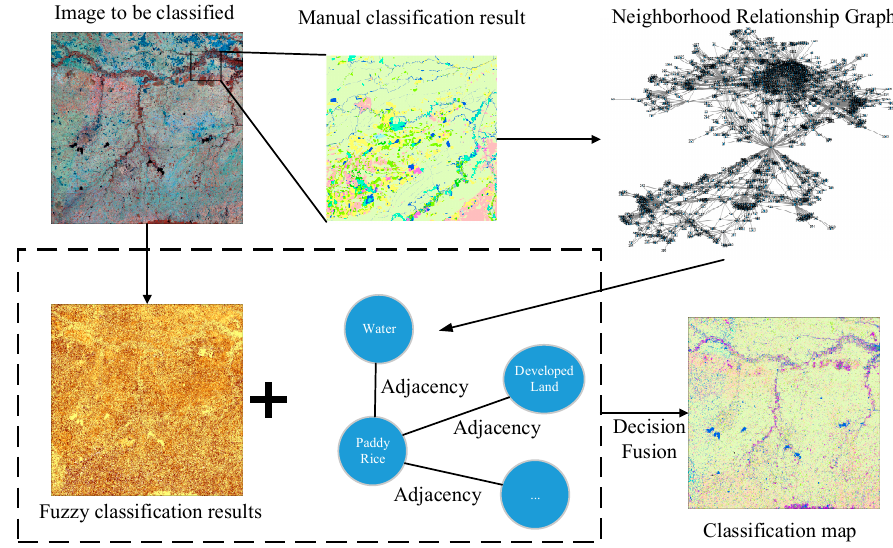
Figure 1. Overview of the proposed framework.